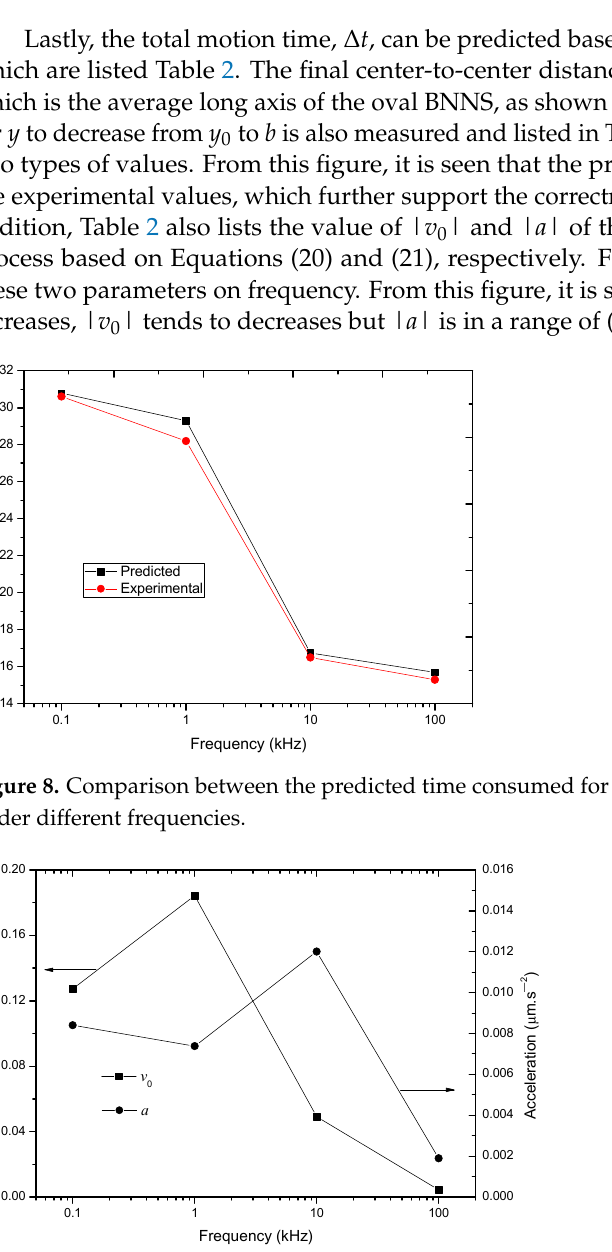
Figure 9. The initial velocity and acceleration of BNNS under different frequencies.